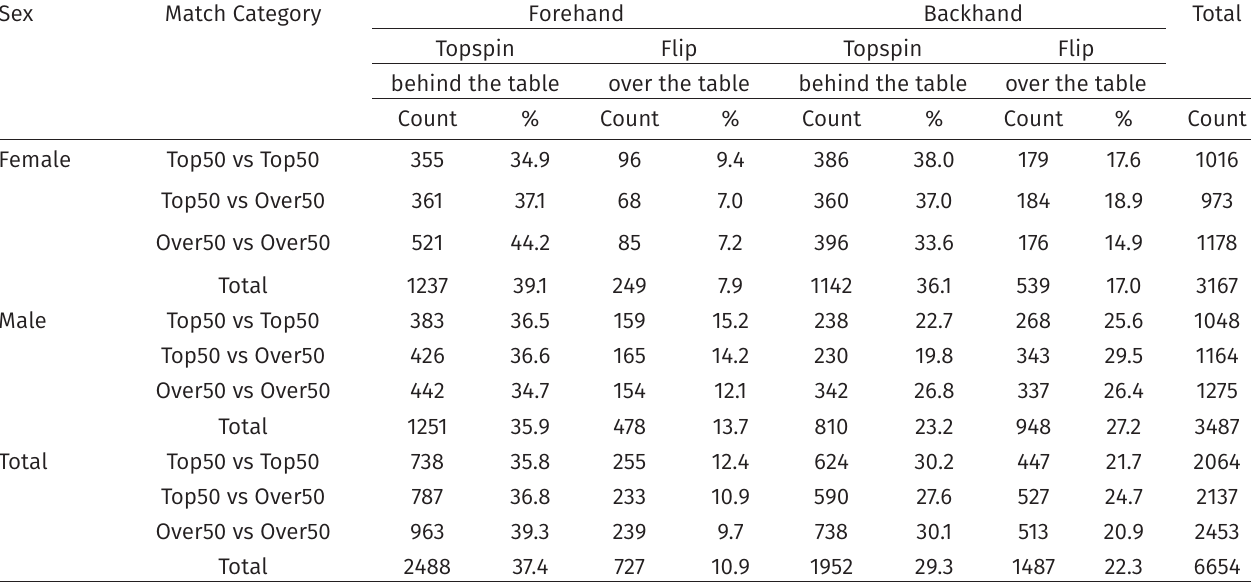
Table 2. Descriptive statistics of FOS laterality-technique-position combination in the two-factor factorial model after excluding marginal shot types. Sex Match Category Forehand Backhand Total Topspin Flip Topspin